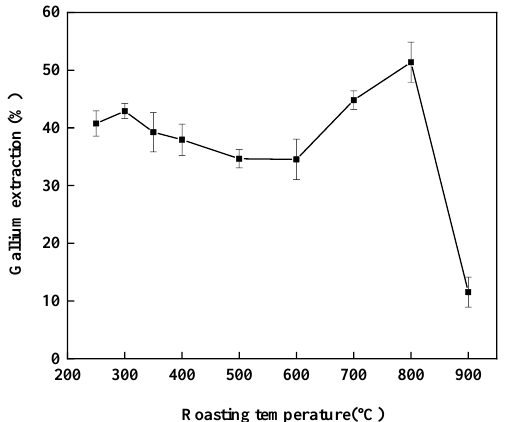
Figure 5. Influence of roasting temperature on gallium extraction (the NaF-CFA mass ratio of 1:1, roasting time of 30 min, leaching temperature of 120 °C, leaching time of 1 h, and HNO 3 concentration of 2 mol/L).